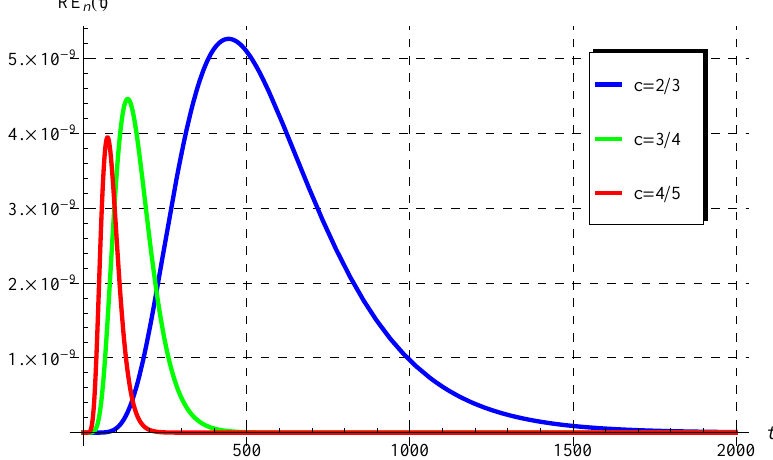
Figure 9. The residuals RE r ( t ) , r = 10,11,12,13 in Equation (76) at various values of c (0 < c < 1) when λ = 1, a = − 1, and b = 1 . 4